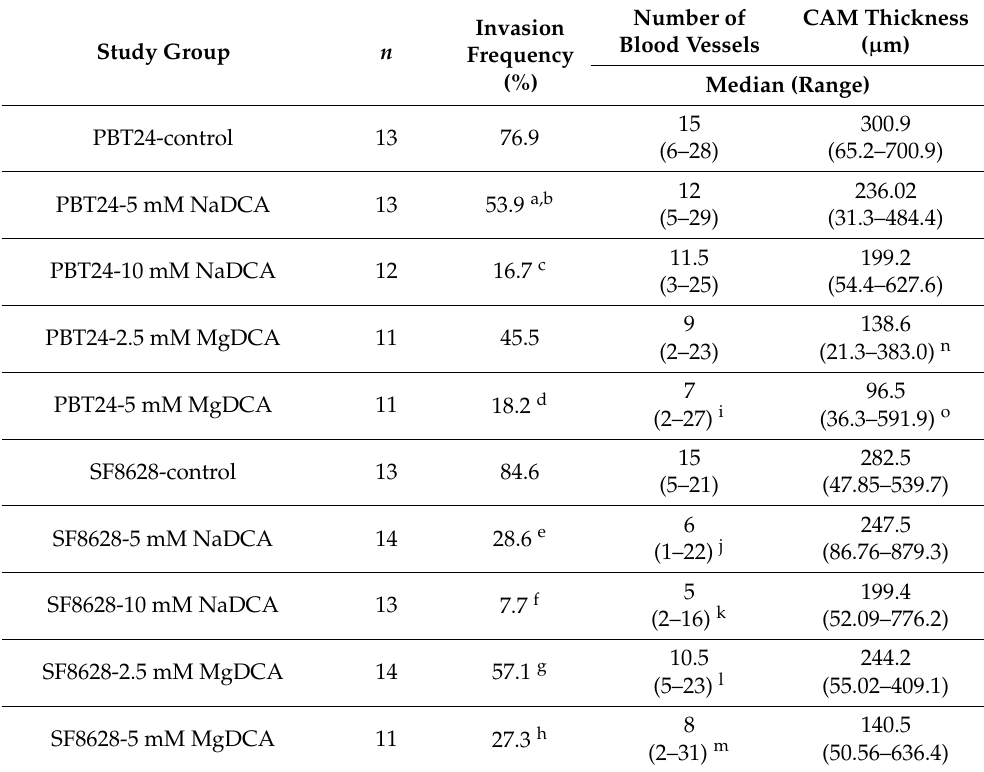
Table 1. The invasion into CAM frequency, the number of a blood vessels in CAM under the tumor, and the CAM thickness data of the PBT24 and SF8628 tumors.